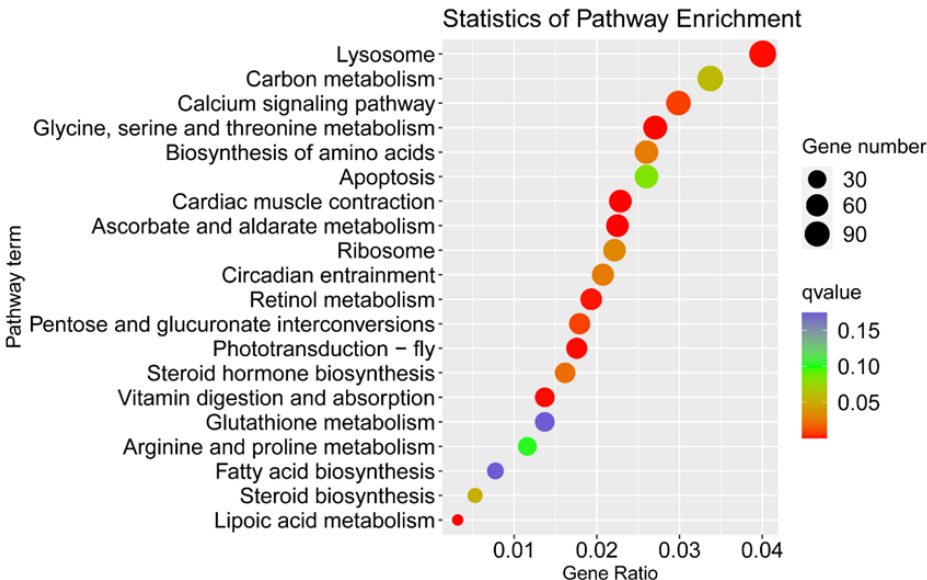
Figure 4. KEGG enrichment of the male-biased genes. The size of the dots corresponds to the number of DEPs in each pathway. The color displays the significance of the